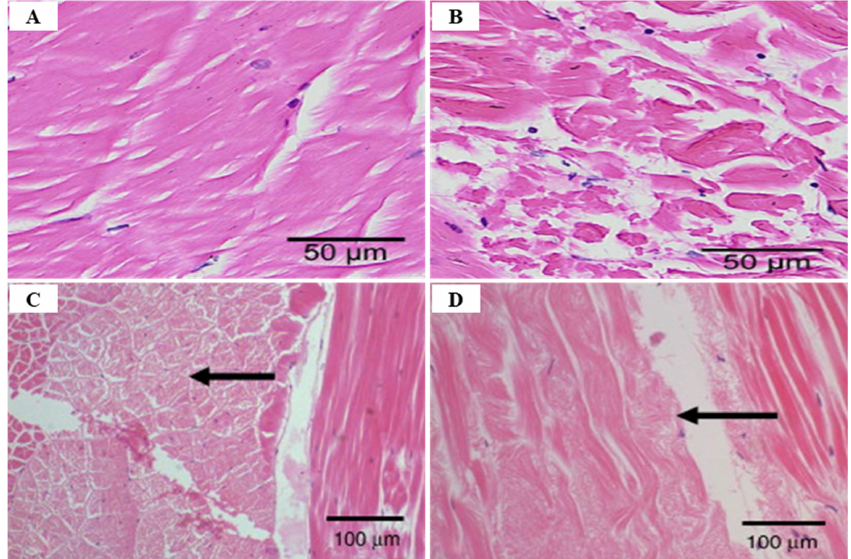
Figure 23. Histological changes in shrimp tissues when infected with White tail disease (WTD) and stained with H&E. ( A ) Uninfected shrimp; ( B ) Histological detection included the aggregation of cells into clumps of various sizes and coagulative necrosis in P. vannamei skeletal muscle (72 h post- infection); ( C , D ) Muscle degeneration and necrotic muscle tissues in Mr NV-infected C. quadricarinatus (arrow). (( A , B ) Reprinted from Aquaculture, Vol. 483, Jariyapong, P., Pudgerd, A., Weerachatyanukul, W., Hirono, I., Senapin, S., Dhar, A.K., Chotwiwatthanakun, C., Construction of an infectious Macrobrachium rosenbergii nodavirus from cDNA clones in Sf9 cells and improved recovery of viral RNA with AZT treatment, p. 9, Copyright (2018), with permission from Elsevier; ( C , D ) Reprinted from Aquaculture, Vol. 319 (1 – 2), Hayakijkosol, O., La Fauce, K., Owens, L., Experimental infection of redclaw crayfish ( Cherax quadricarinatus ) with Macrobrachium rosenbergii nodavirus, the aetiological agent of white tail disease, p. 5, Copyright (2011), with permission from Elsevier).